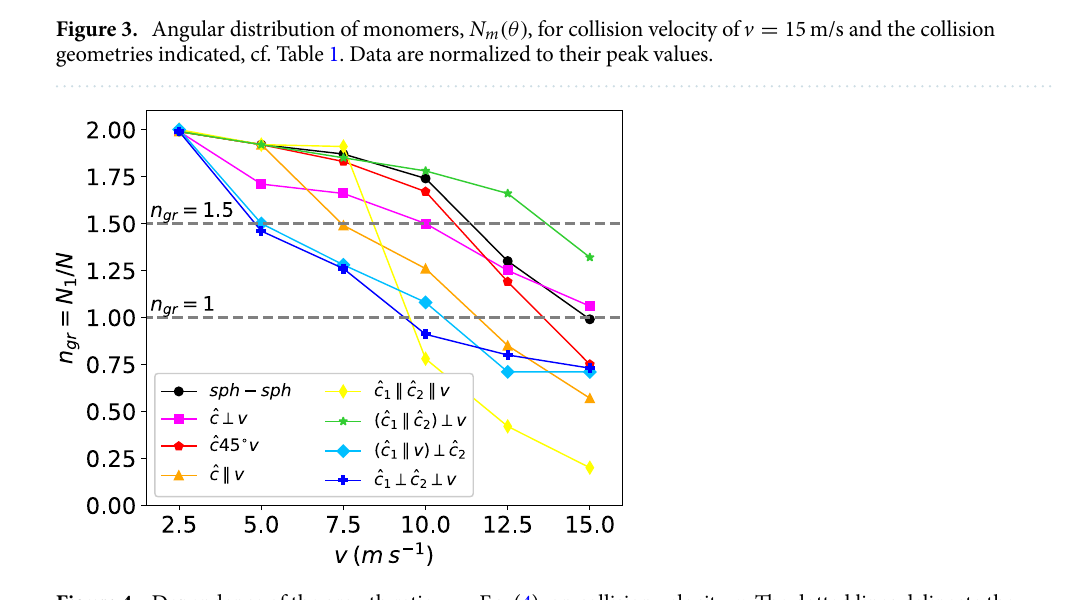
Figure 4. Dependence of the growth ratio, n gr , Eq. (4), on collision velocity, v . The dotted lines delineate the growth regime, n gr > 1 , and the fusion regime, n gr > 1.5